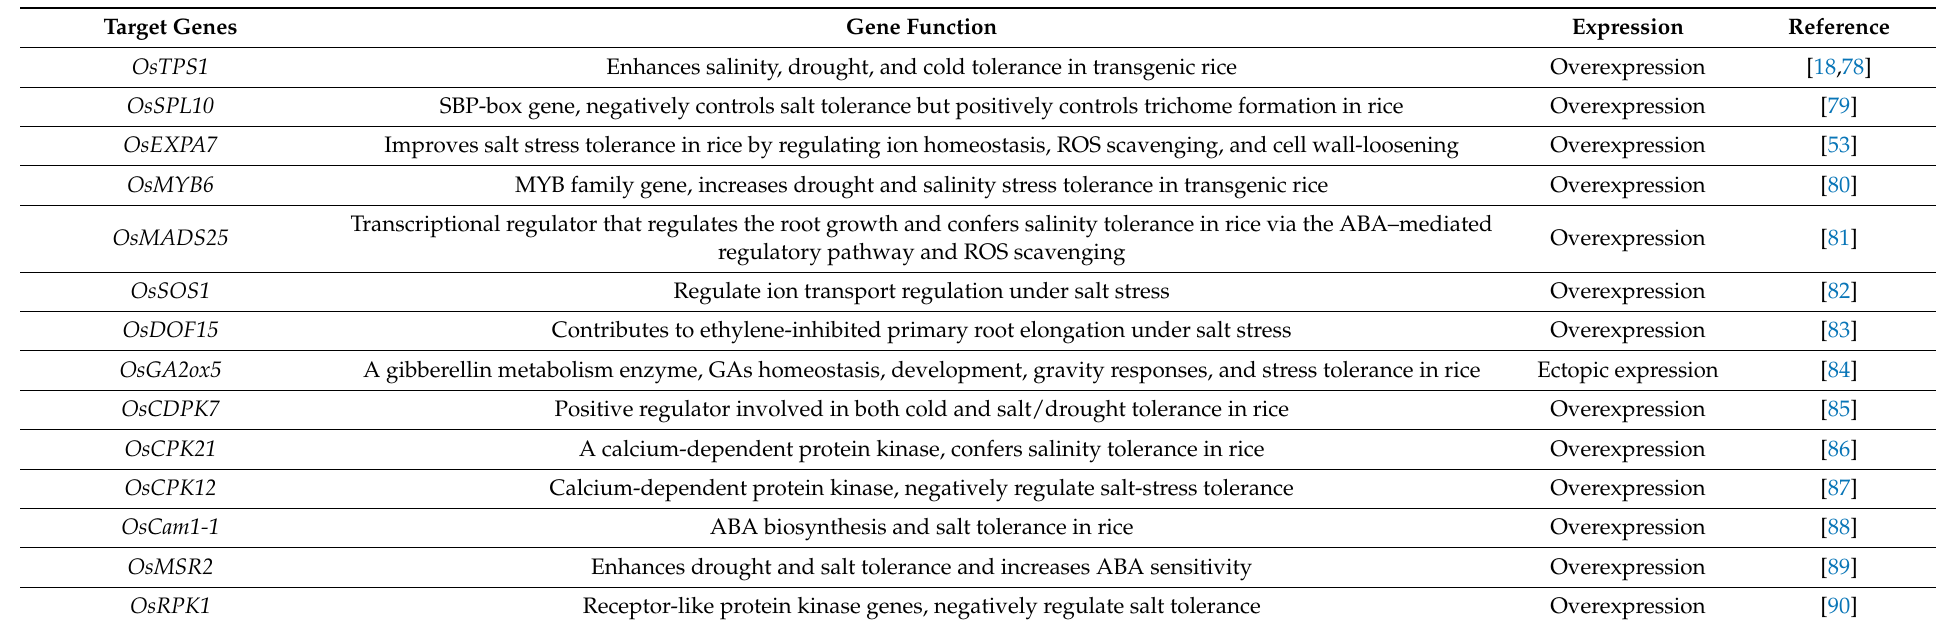
Table 2. List of salinity tolerance genes and their functions for breeding of salt-tolerant